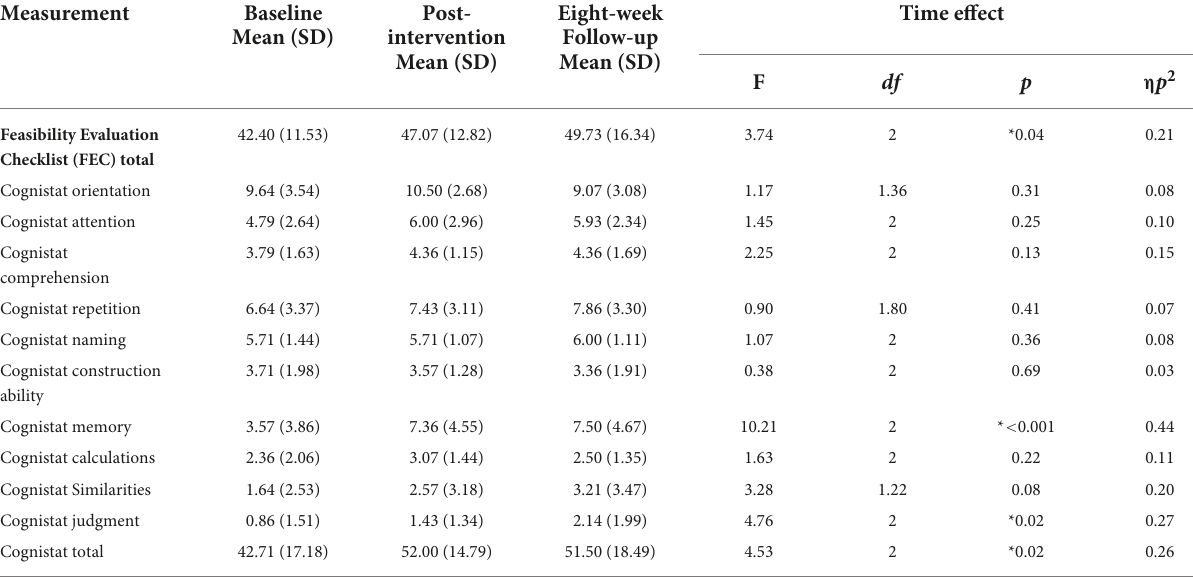
TABLE 3 Repeated measures for Feasibility Evaluation Checklist (FEC) total scores and Cognistat domain and total scores at baseline, post-training, and at eight-week